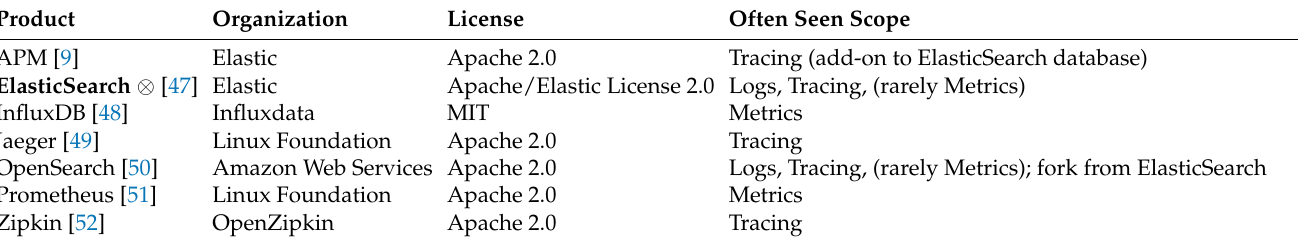
Table 1. Often seen databases for telemetry data consolidation. Products used in this study are marked bold ⊗ , without claiming completeness.